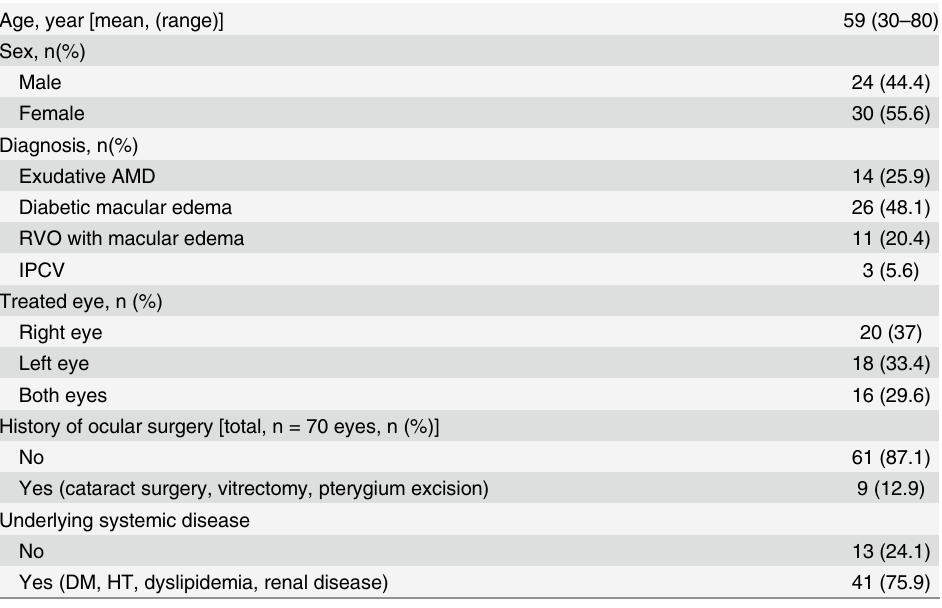
Table 1. Baseline demographic and ocular characteristic of study